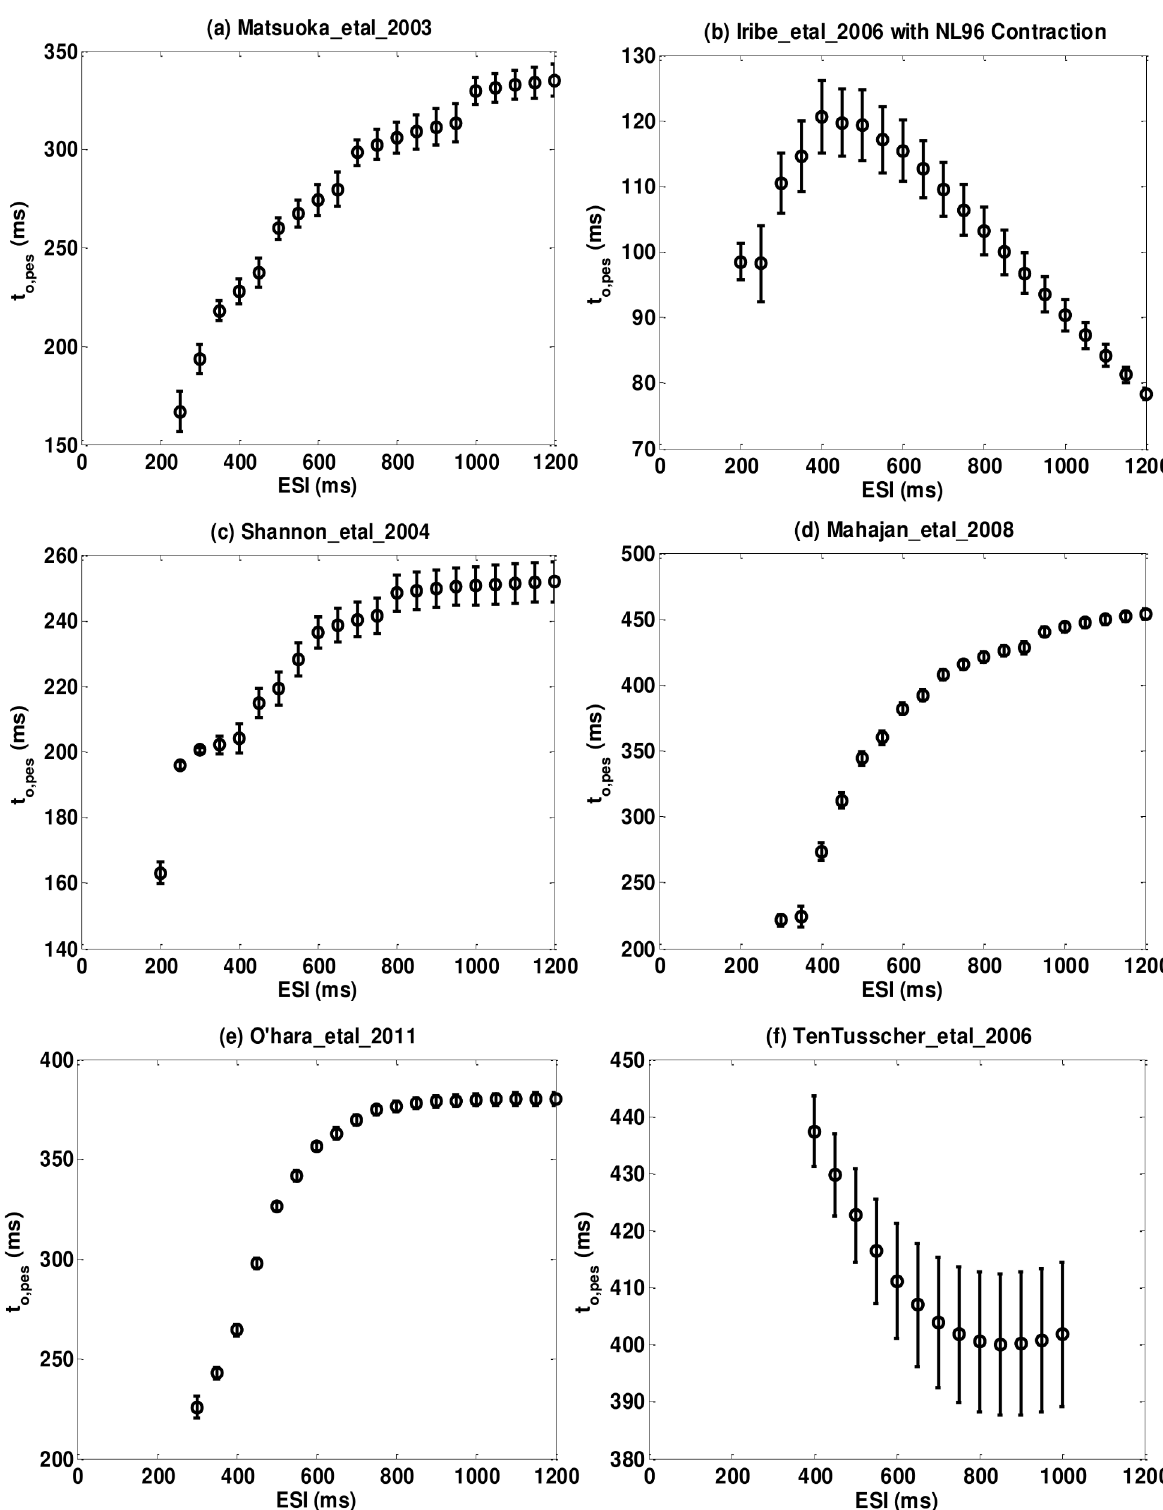
Fig 9. Representative minimum-value axis intercept curve ( t o , pes ) for six models. (a) Matsuoka_etal_2003; (b) Iribe_etal_2006; (c) Shannon_etal_2004; (d) Mahajan_etal_2008; (e) O ’ hara_etal_2011; (f) TenTusscher_etal_2006. 95% confidence bounds of t o , pes are plotted as error bars.